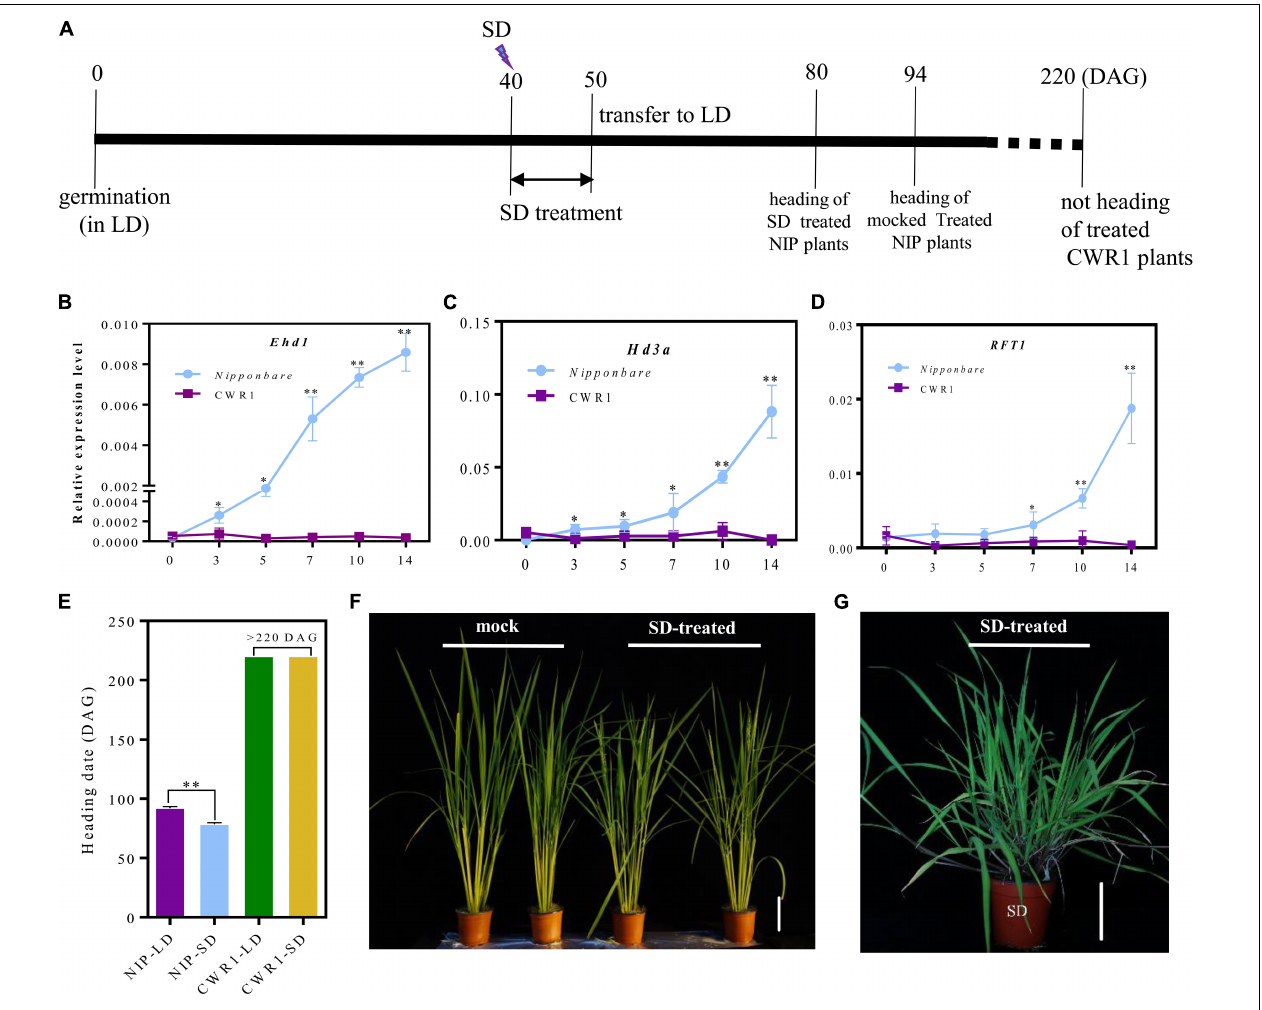
FIGURE 6 | The photoperiod response to 10 days SD-treatment from 40 DAG to 50 DAG in Nipponbare and O. rufipogon (CWR1) plants. (A) Scheme for SD treatment. (B–D) The expression pattern of Ehd1 , Hd3a , and RFT1 in the plants of Nipponbare and O. rufipogon (CWR1) with 10 days SD-treatment. The y -axis shows the relative expression levels of genes with rice Os Ubi1 as an internal control; the x -axis presents the day of SD treatment. Values are means ± SD ( n = 5). *, ** significant differences by student’s t -test at P ≤ 0.05 and P ≤ 0.01, respectively. (E) The heading date for LD-grown plants and SD-treated plants. (F) Phenotypes of mock (left) and SD-treated Nipponbare plants (right). (G) The phenotype of CWR1 with 10 days SD-treatment at 80 DAG. Bar = 10 cm in (F,G)